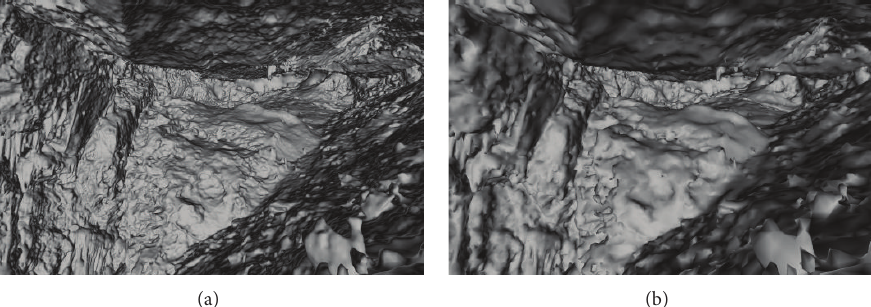
Figure 2: The 3 D model of the cave chamber with 10 038 522 triangles (a) and its simplification after decimation process with 249 934 triangles for Web3D (b).